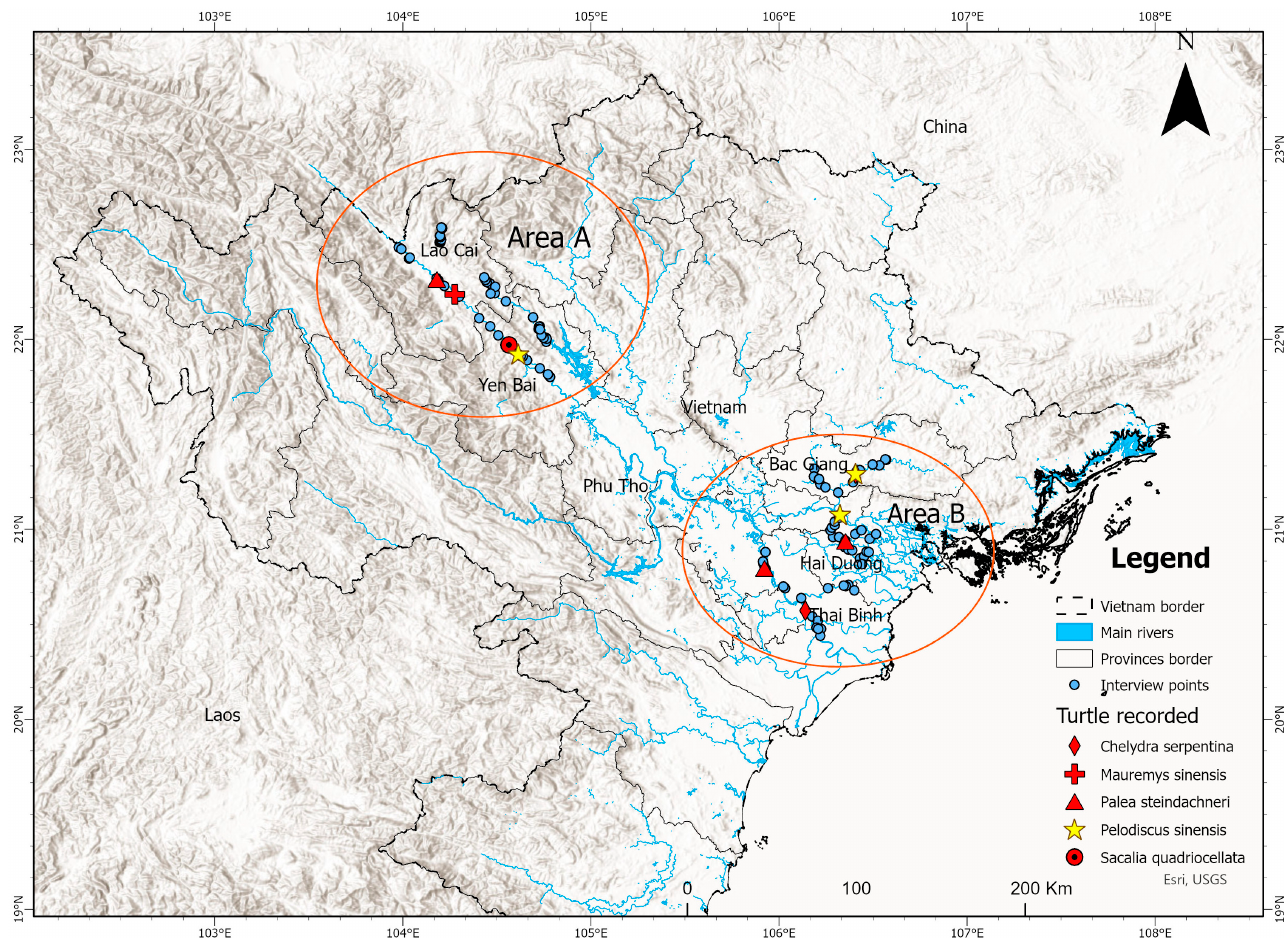
Figure 1. Map of northern Vietnam showing (i) the sites where interviews with local fishers were carried out during our survey (blue spot), and (ii) the sites of sighting of the various turtle species recorded during the interviews, in the two study areas. Area (A) includes the Red River and Chay River in Lao Cai and Yen Bai provinces, and area (B) includes Bac Giang, Hai Duong, Thai Binh, and Hung Yen provinces, along the Luc Nam River, Thuong River, Kinh Thay River, Kinh Mon River, and Thai Binh River, Luoc River and Red River.